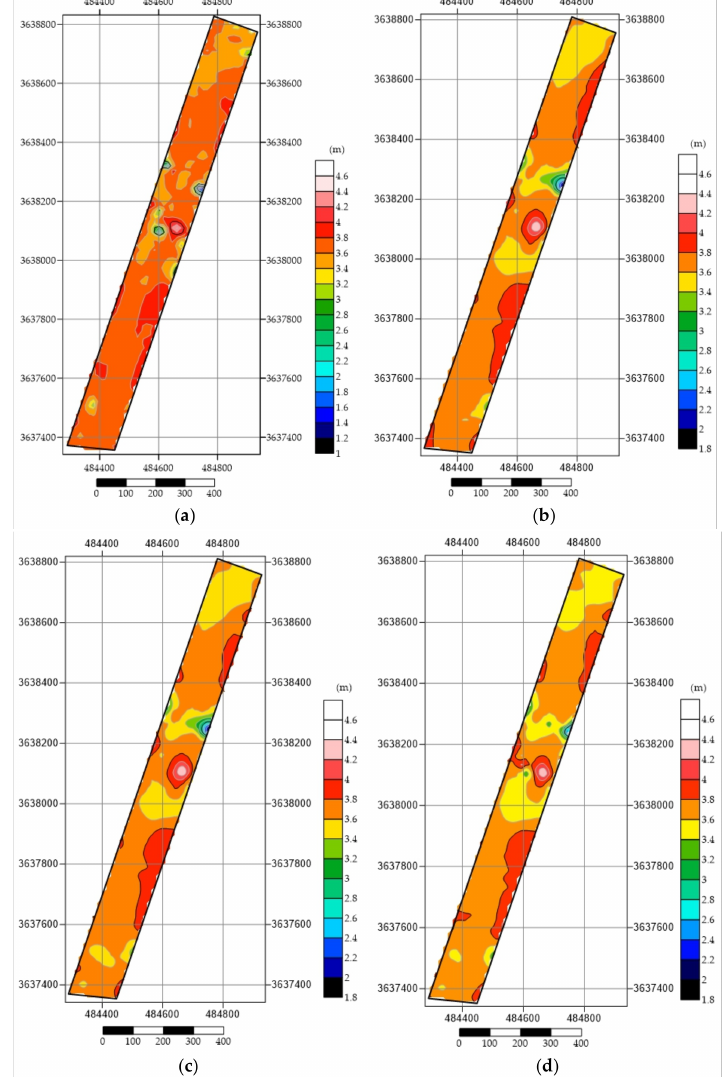
Figure 6. ( a ) Actual coal thickness distribution, ( b ) predicted coal thickness distribution—Model A, ( c ) predicted coal thickness distribution—Model B, and ( d ) predicted coal thickness distribution— Model